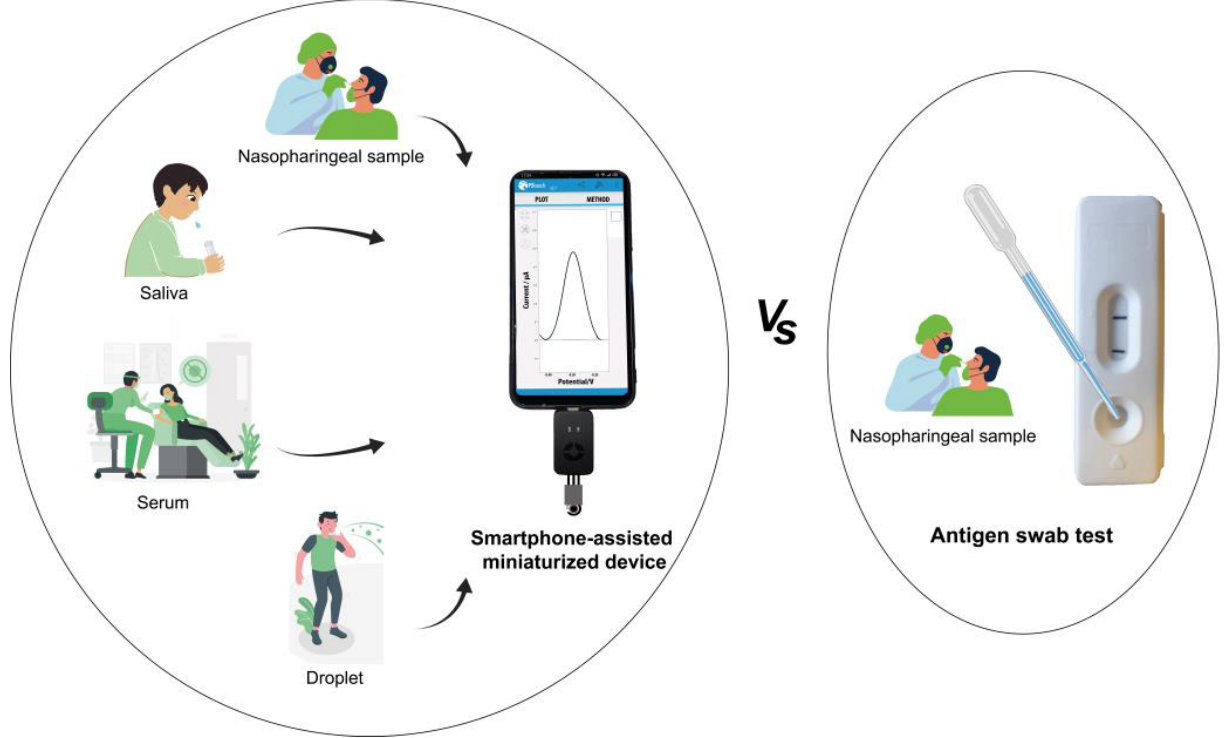
Figure 2. Different matrices used for the development of antigen biosensors at an academic level vs. commercially available antigen kits. Table 1. Commercially available antigen kits.